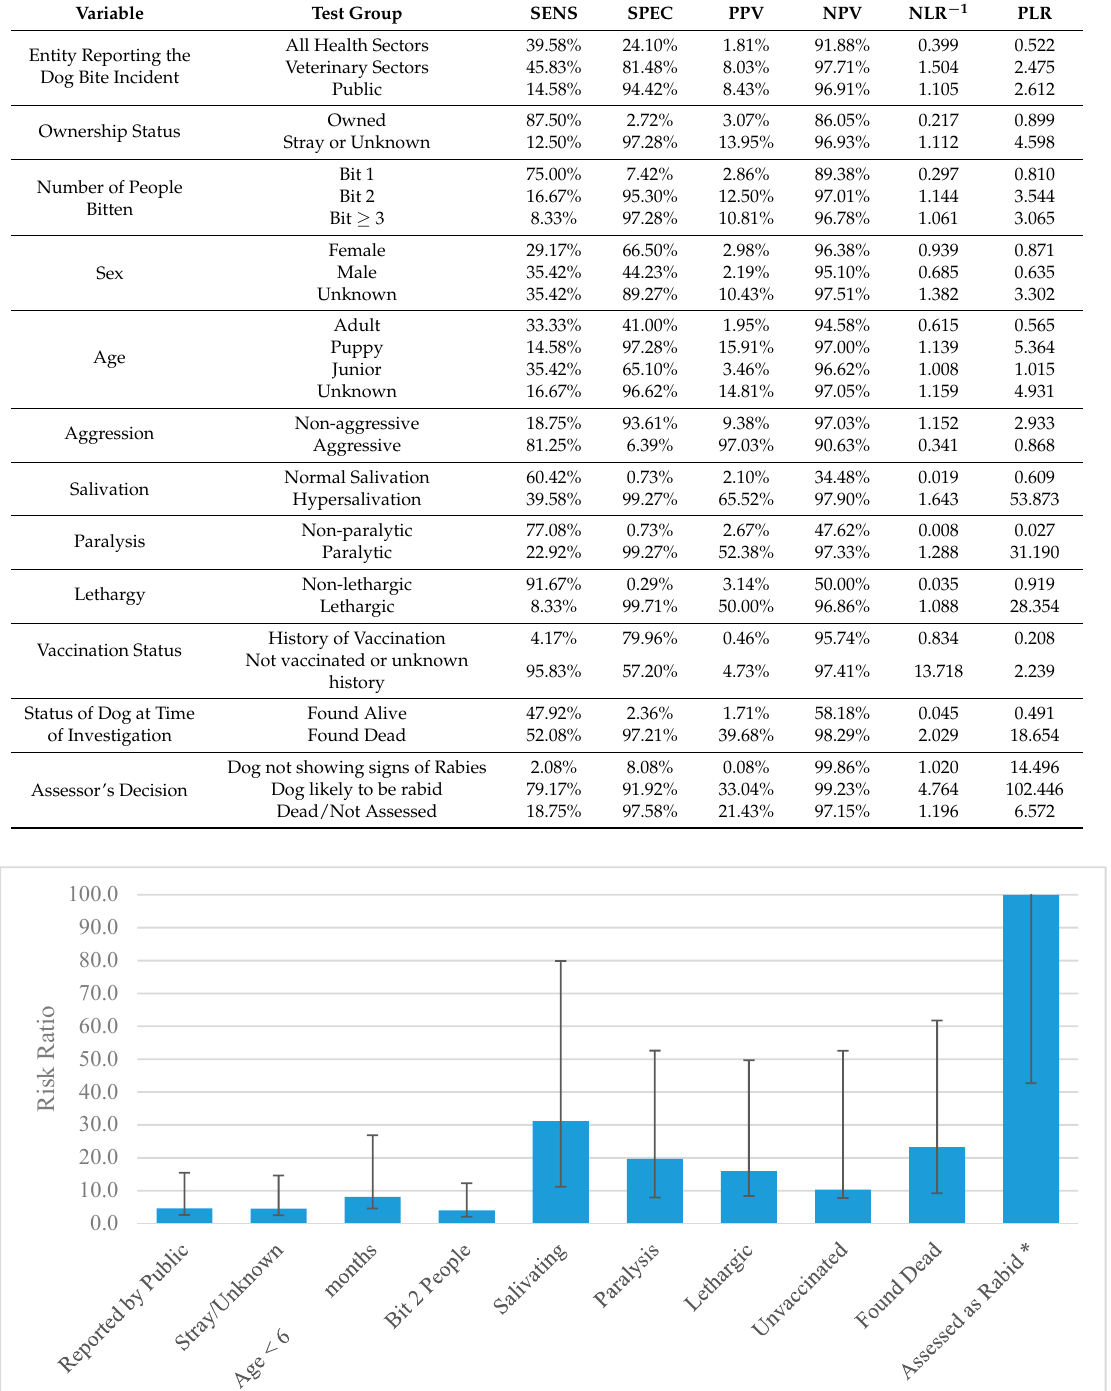
Table 3. Sensitivity, specificity, positive predictive value, negative predictive value, negative likelihood ratio, and positive likelihood ratio of the 12 dog bite-related variables. Variable